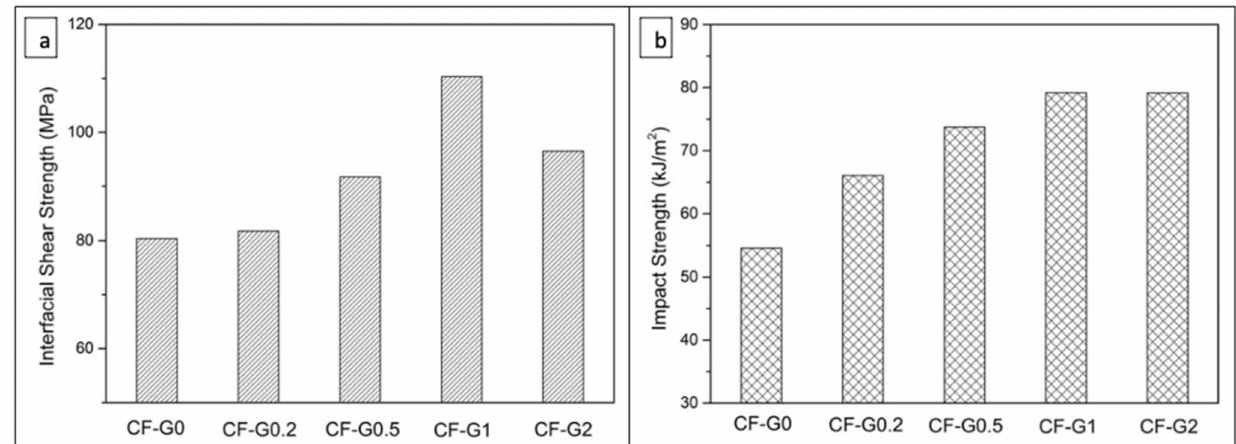
Figure 9. ( a ) Interfacial shear strength; ( b ) impact strength variation with (0, 0.2, 0.5, 1, 2) GO wt.% content [79]. Obtained with permission from Applied Surface Science; published by Elsevier,